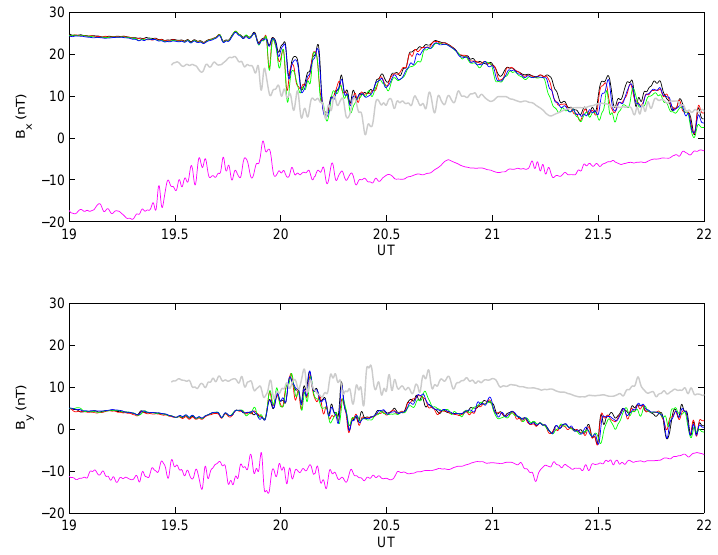
Fig. 2. The low-pass filtered ( τ ≥ 1 . 5min) magnetic field data, B x and B y , for Cluster (usual colours) and TC-1 (solid magenta line). The gray line shows the TC-1 data shifted by 29min and sign-reversed to compensate for the opposite hemispheres.